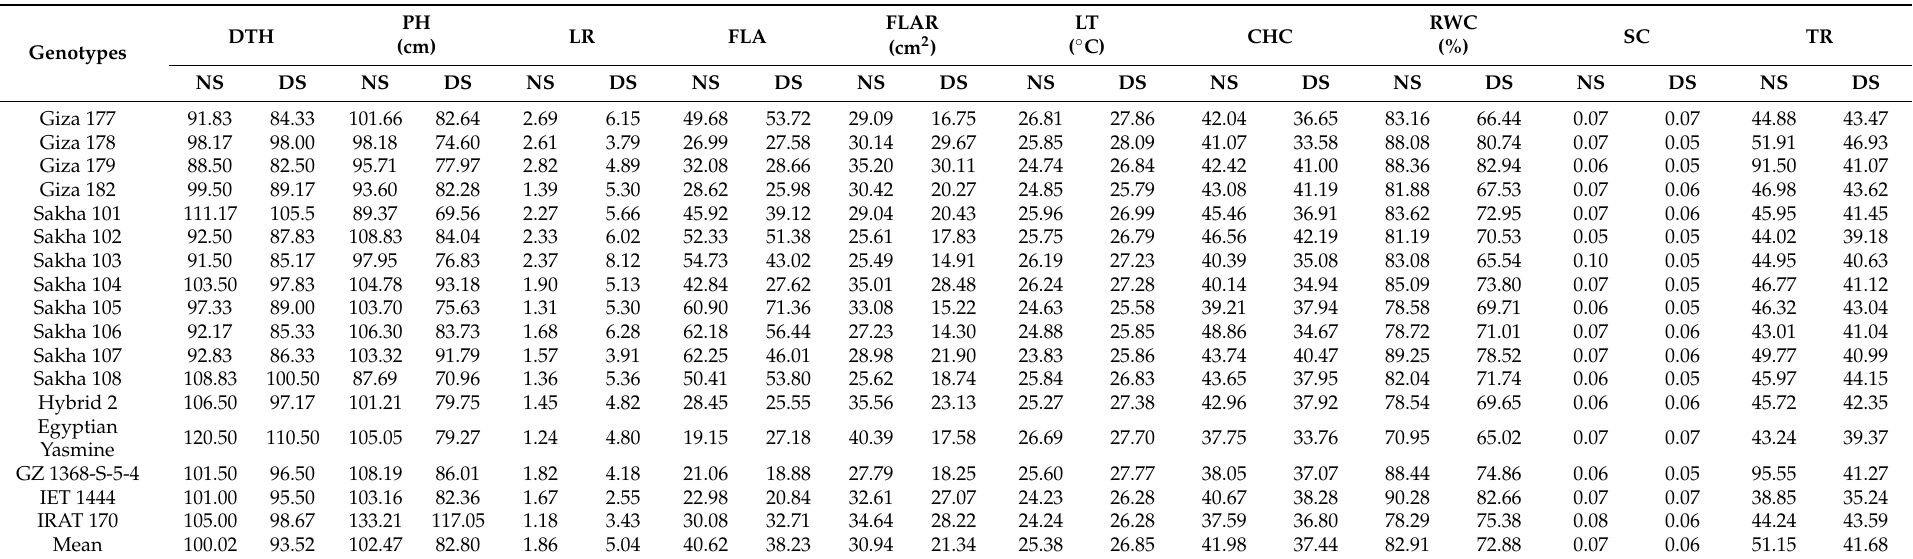
Table 5. Morpho-physiological traits performance of rice genotypes under water-deficit (DS)